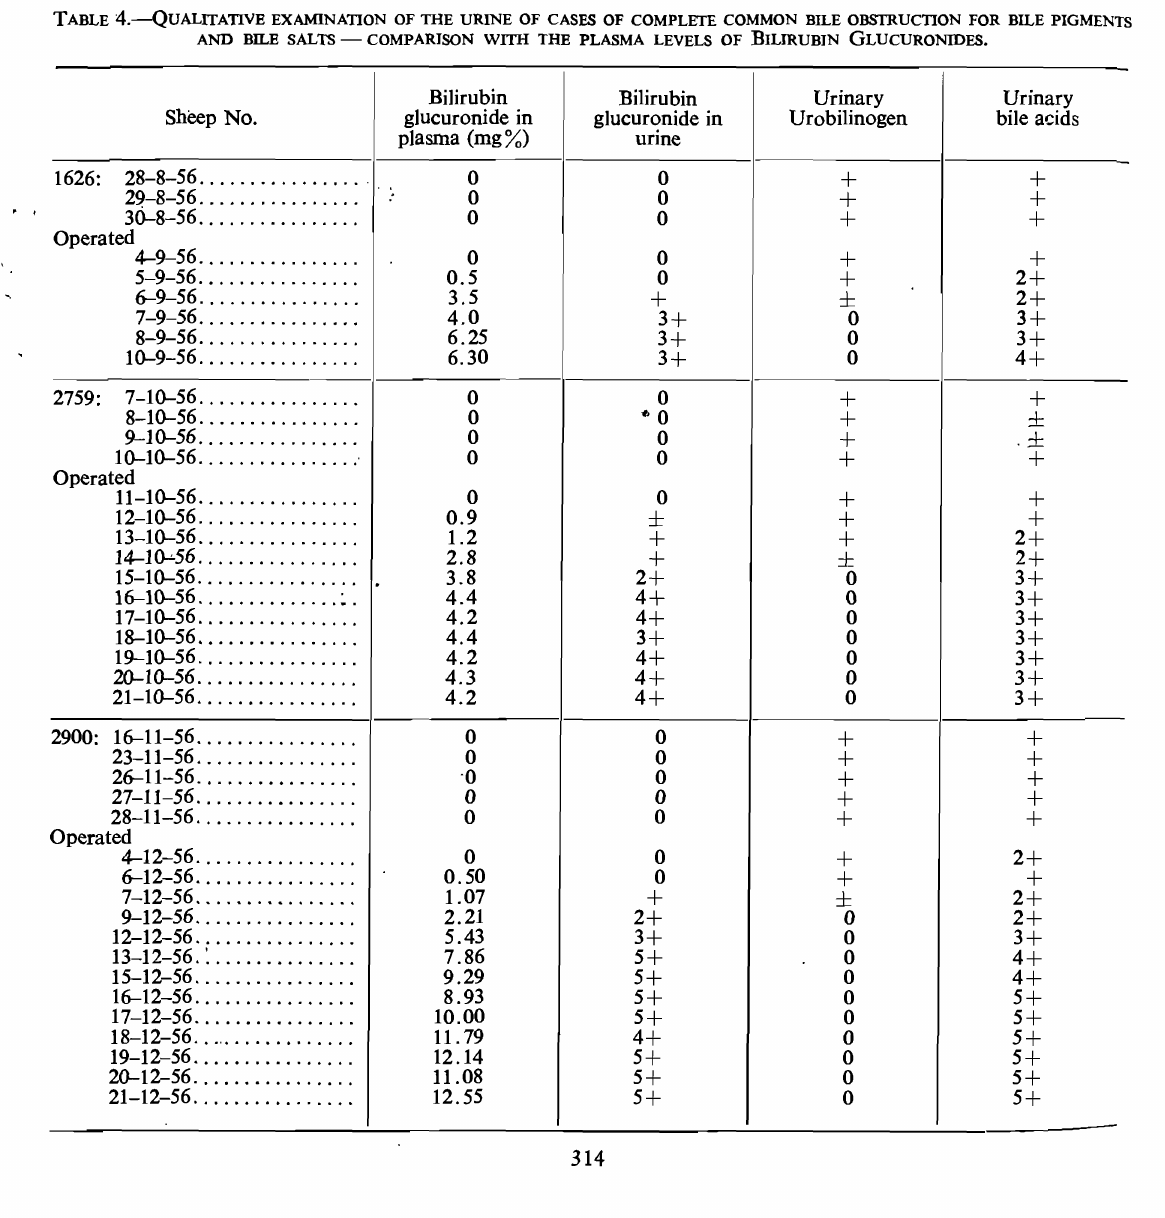
TABLE 4.--QUALITATIVE EXAMINATION OF THE URINE OF CASES OF COMPLETE COMMON BILE OBSIRUCTION FOR BILE PIGMENTS AND BILE SALTS - COMPARISON WITH THE PLASMA LEVELS OF BILIRUBIN GLUCURONIDES. Bilirubin Bilirubin Urinary Urinary Sheep